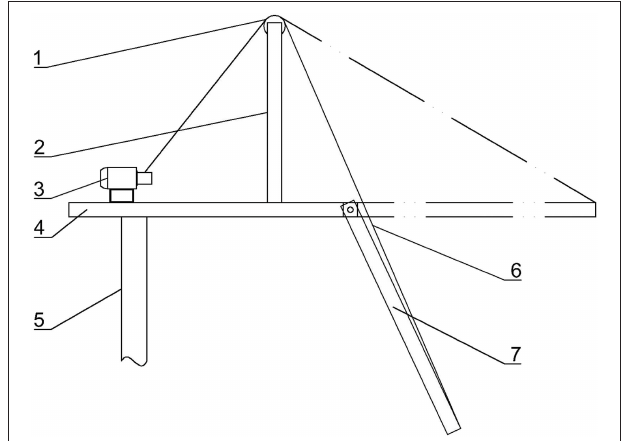
FIGURE 6 | Extension mechanism (1: pulley, 2: support frame, 3: motor and winch, 4: top platform, 5: fourth-level rail, 6: steel wire rope, 7: extension frame).